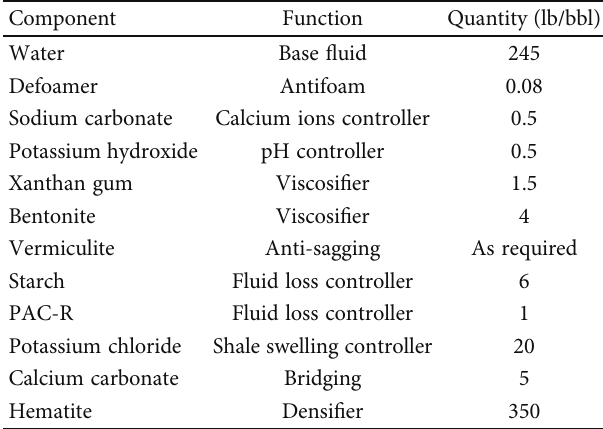
Table 1: The WBDF